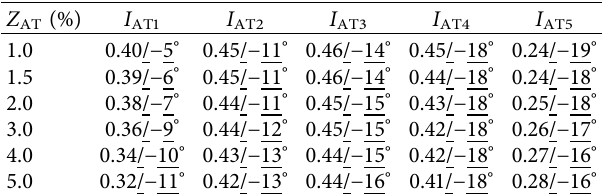
� 1% are shown without parenthesis, whereas results AT Table 5: Autotransformer currents (in pu) for the example with six trains and the nonlinear method. Second